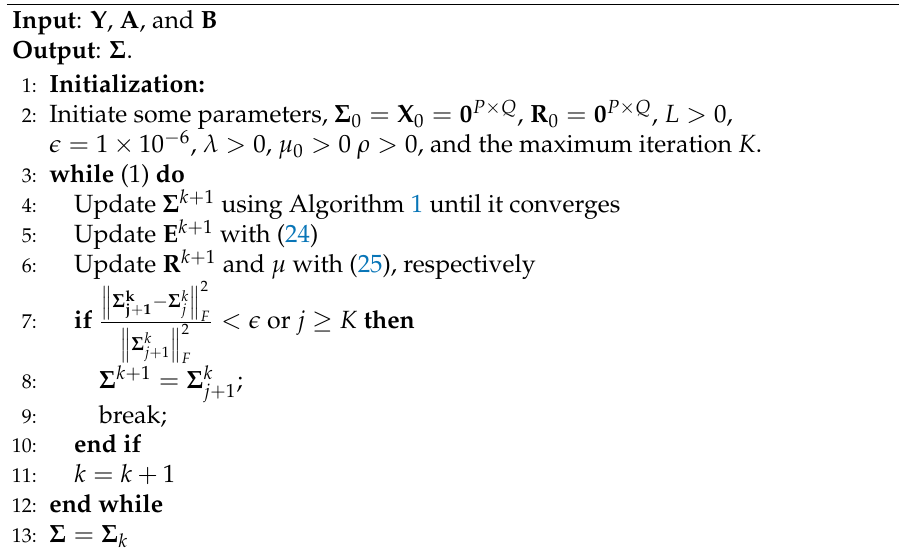
Algorithm 3 The exact sparse algorithm.